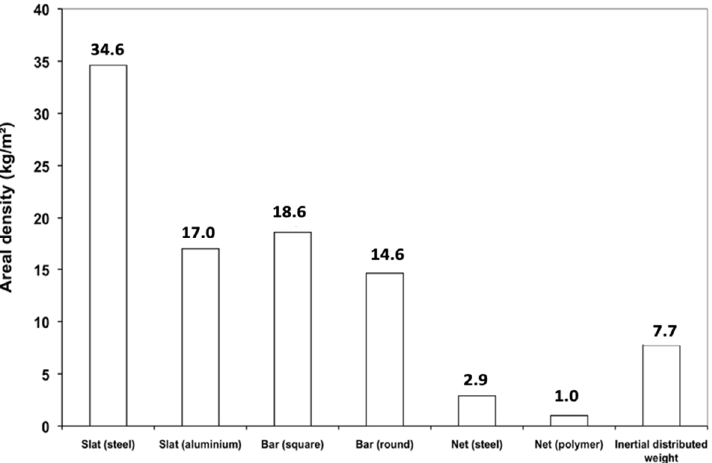
Figure 24. Areal densities for the different considered cage armour systems.